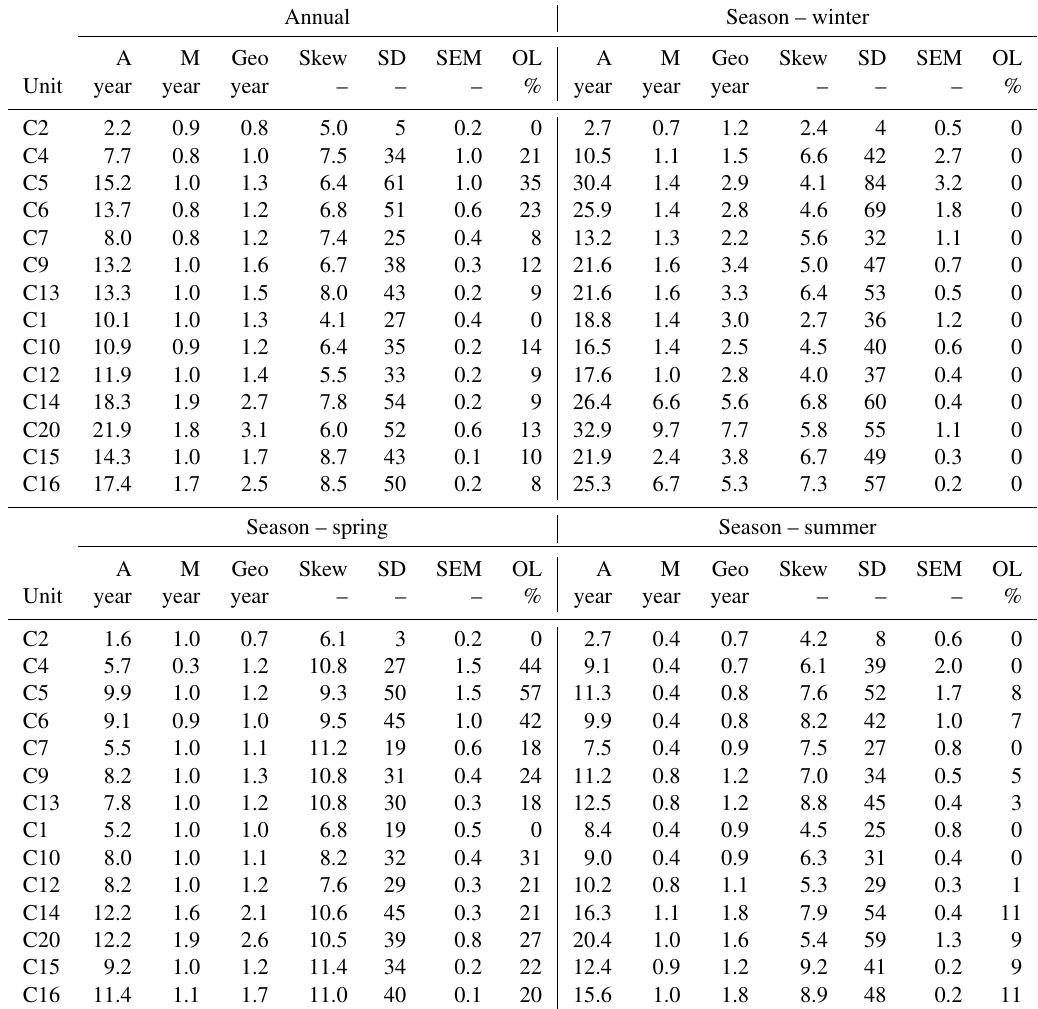
Table A2. Extended version of Table 5 – annual and seasonal (winter, spring, and summer) travel time results . The table includes the travel time results based on particle tracking before taking the overland flow into account. The results include arithmetic mean (A), median (M), geometric mean (Geo), skew, standard deviation (SD), and standard error of the mean (SEM). The table also shows the fraction of overland flow (OL) used as a scaling factor for the calculation of